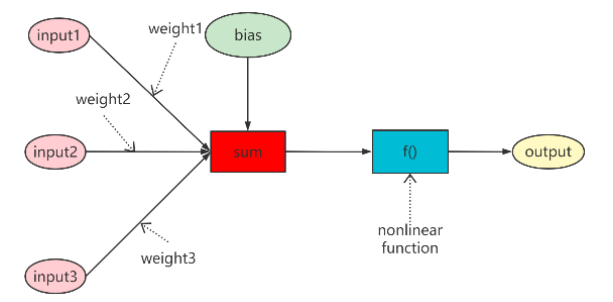
Figure 2. Neural network